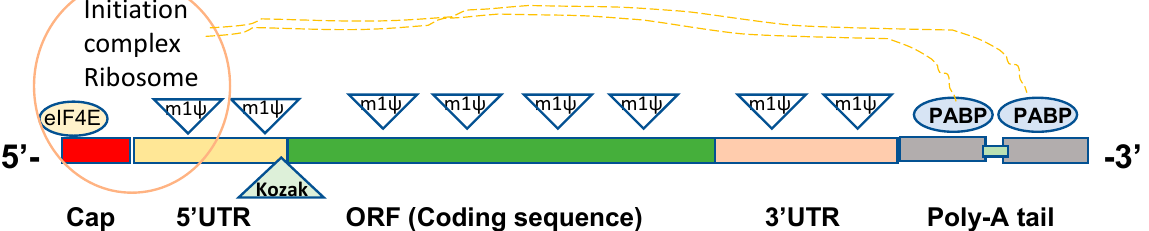
Figure 1. Structural elements for effective in vitro transcription of mRNA. 5 ′ Cap: 7-methylguanosine (m7GpppN) or additional methylation (Cap1: m7GpppN m pN) required for recognition by eukaryotic translation initiation factor 4E (eIF4E); 5 ′ UTR and 3 ′ UTR: 5 ′ and 3 ′ untranslated regions required for ribosome binding and translation initiation complex formation; ORF: open reading frame encoding a gene of interest; poly-A tail: recognition by poly-A binding protein (PABP) to initiate translation, forming a hypothetical loop structure with initiation ribosome complex; m1 ψ : N1-methylpseudouridine instead of uridines; Kozak: the Kozak sequence.